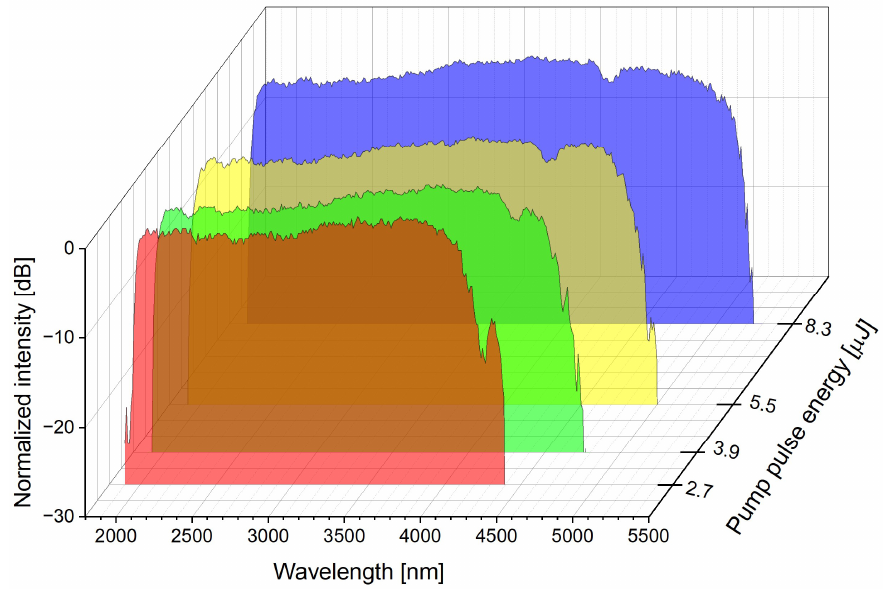
Figure 6. SC spectra obtained from the InF 3 fiber pumped at 2.02 μm, recorded for injected pump pulse energies of ~2.7 μJ (36.3 kW), 3.9 μJ (52.4 kW), 5.5 μJ (73.9 kW), and 8.3 μJ (111.5 kW). Repro- duced under the terms of the Creative Commons CC BY license [103]. Copyright 2016, The Authors, published by Springer Nature.